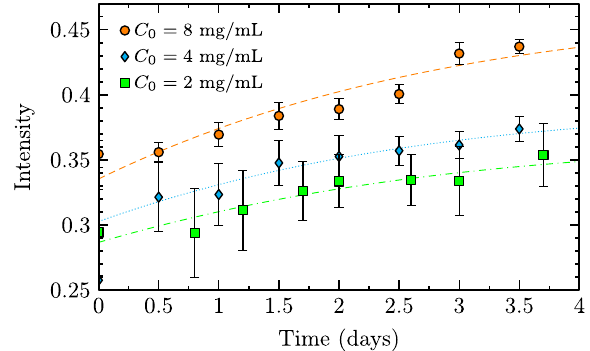
Fig. 2 Intensity of scattered light verses time for pre-sheared insulin cases. ± 1 standard deviation error bars represent measure- ment uncertainty and dashed lines represent sigmoidal fi ts to a theoretical fi brillization function (Eq. 1) presented in the Methods